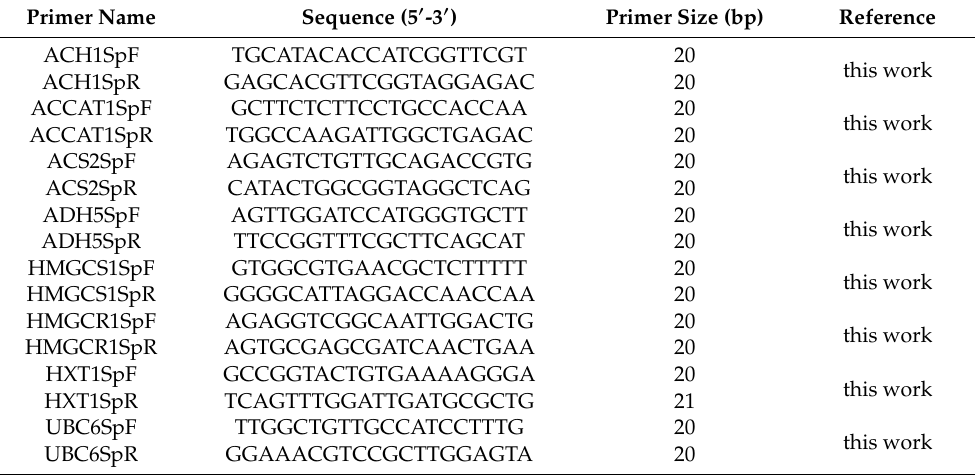
Table 2. Primers used for gene expression analysis in Schi. pombe